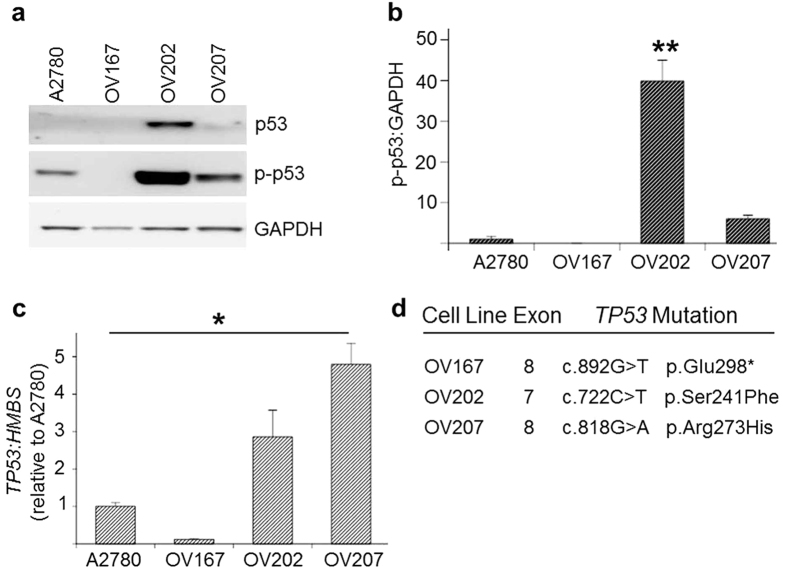
p53 protein and transcript levels in previously uncharacterized HGSOC cell lines (OV167 and OV202) and clear cell carcinoma cell line (OV207) compared to a wild-type p53 cell line (A2780).(a) Representative Western blots of basal levels of p53 and phosphorylated p53 (Ser15) (p-p53). (b) Graphical representation of protein levels of basal p-p53 in TP53 mutant ovarian cancer cell lines relative to A2780 (N = 3, mean ± S.E.M, **P < 0.01). (c) Graphical representation of TP53 transcript levels relative to the reference gene HMBS in ovarian cancer cell lines compared to A2780 (N = 3, mean ± S.E.M, *P < 0.05). (d) TP53 mutations identified by our Fluidigm-MiSeq analysis pipeline in previously uncharacterised ovarian cancer cell lines.